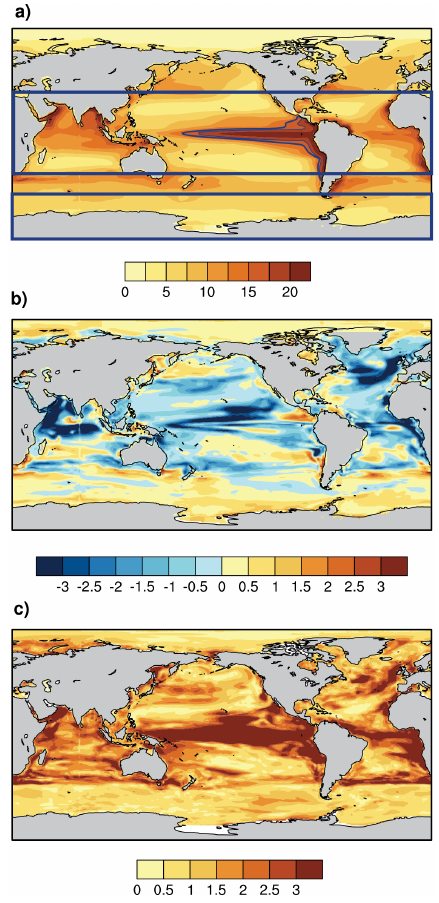
Figure 3. Spatial patterns of multi-model annual mean integrated net primary production (NPP) for (a) the 2012–2031 average, (b) changes between 2081–2100 and 2012–2031 under RCP8.5 and (c) interquartile range of the changes in NPP projections. The unit ismolCm − 2 yr − 1 . The blue boxes in (a) mark the regions which are discussed in more detail in this work, namely the Southern Ocean south of 50 ◦ S, the low latitudes (30 ◦ S–30 ◦ N) and the equa- torial upwelling region in the Pacific.